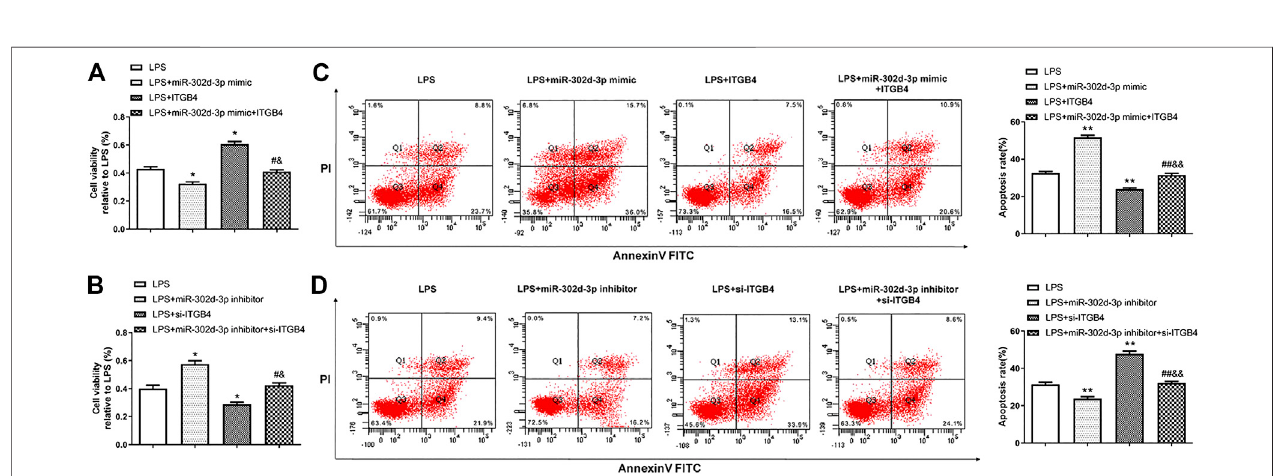
FIGURE 4 | miR-302d-3p/ITGB4 axis modulates LPS-treated CHON-001 cells viability and apoptosis. (A,B) CCK-8 assay was utilized to evaluate cell viability of LPS-treatedCHON-001cells.* p < 0.05, # p < 0.05, & p < 0.05. (C,D) Flowcytometryassaywasusedtomeasuretheapoptosisrateofeachgroup.** p < 0.01, ## p < 0.01, && p < 0.01. Results are the average of three individual experiments in triplicate with error bars indicating mean ± SD (ANOVA followed by Tukey ’ s post hoc